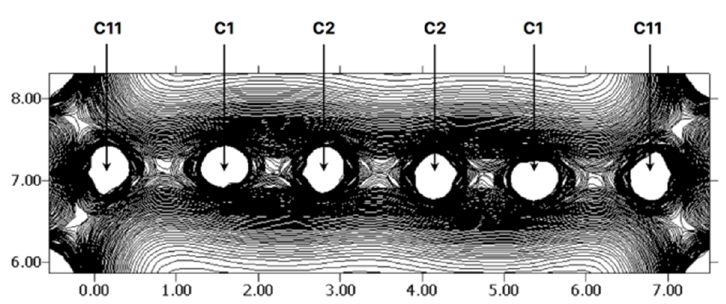
Figure 3. The electron density map ρ bulk (r) of the R-(C11)-C(1)-C(2)-C(2A)-C(1A)-(C11A)-R fragment in the molecular plane. Lateral units in bohr and interval equal 0.005 e / bohr 3 .